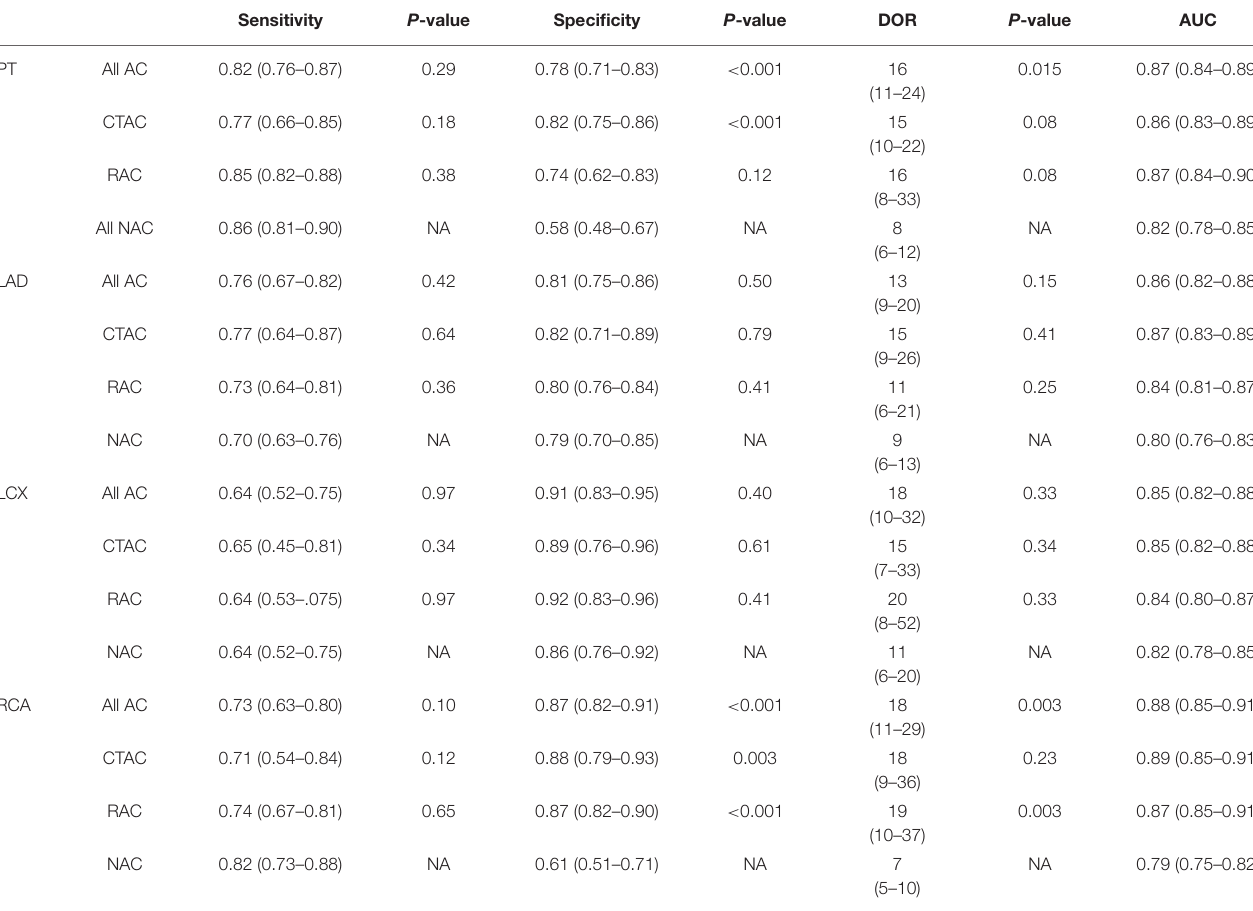
TABLE 2 | Diagnostic performance of MPI, pooled sensitivity, specificity, diagnostic OR and area under the receiver operating characteristic curve of all AC, CTAC, RAC, and NAC in diagnosing CAD at a patient level and detecting LAD, LCX, and RCA stenosis. Sensitivity P